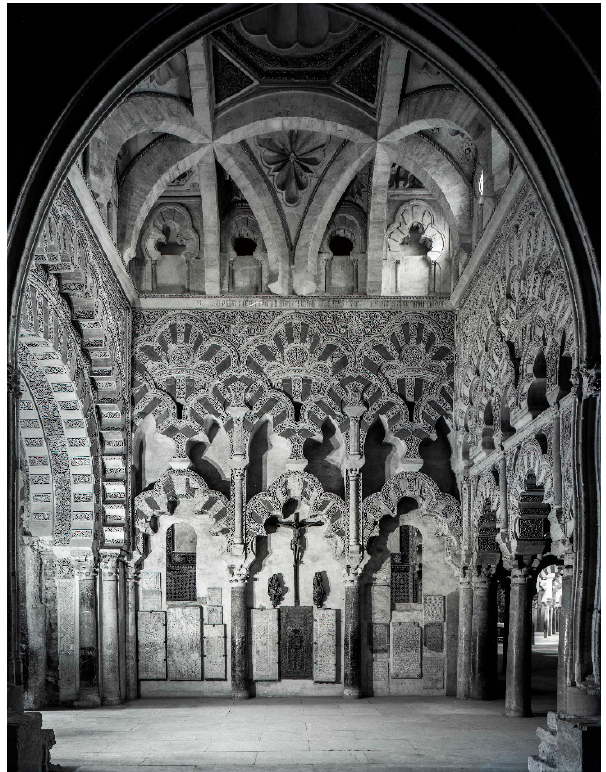
Figure 8. The Capilla de Villaviciosa in the mosque of Córdoba, part of the extension executed by al- Ḥ akam II. Photograph by R. Friedrich, German Archaeological